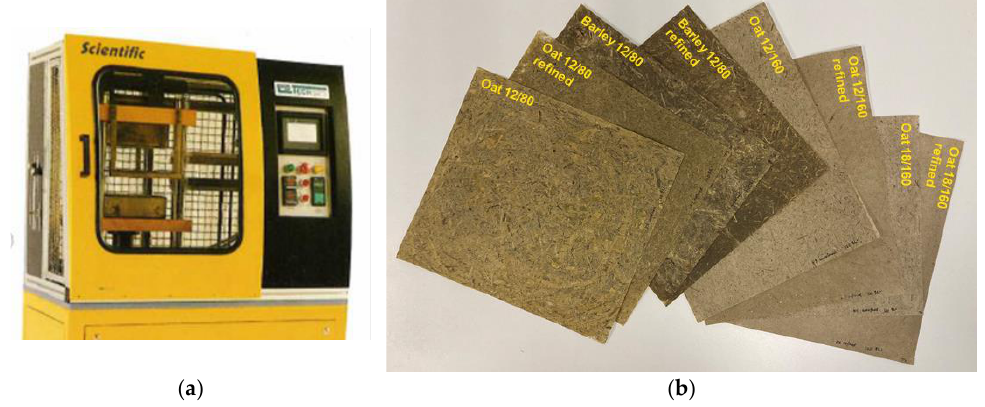
Figure 3. ( a ) Laboratory pressing device; ( b ) examples of produced sheets.